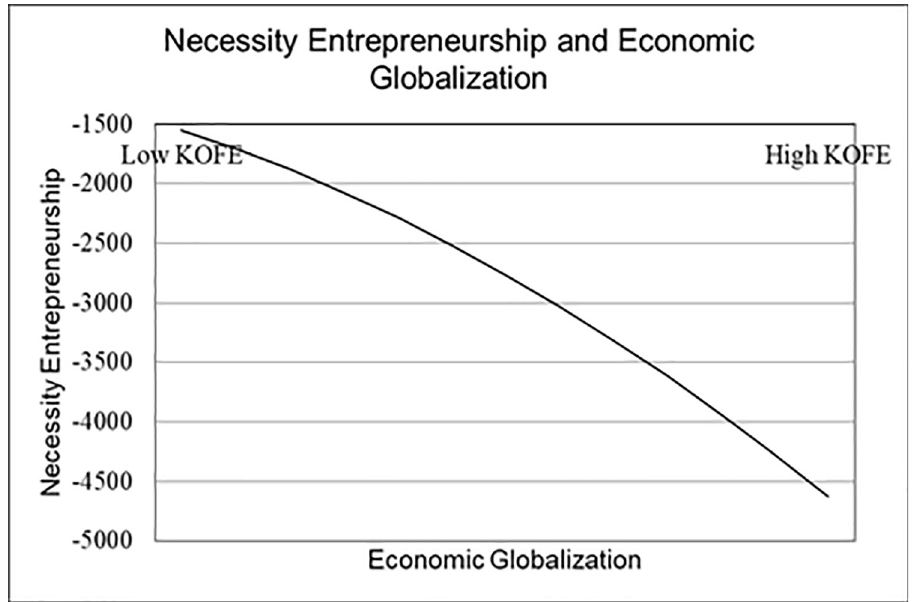
Fig 5. Quadratic fit of necessity entrepreneurship and economic globalization.